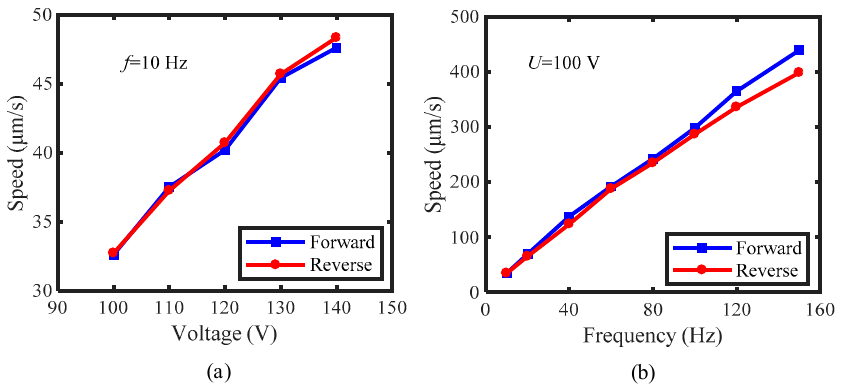
Figure 7. ( a ) Forward and reverse speeds obtained under the fixed driving frequency of 10 Hz and various driving voltages, and ( b ) forward and reverse speeds obtained under the fixed driving voltage of 100 V and various driving frequencies.